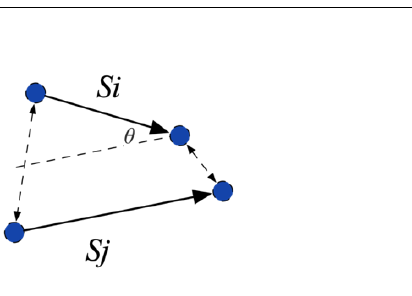
Figure 9. Diagram of angular distance between trajectory segments.